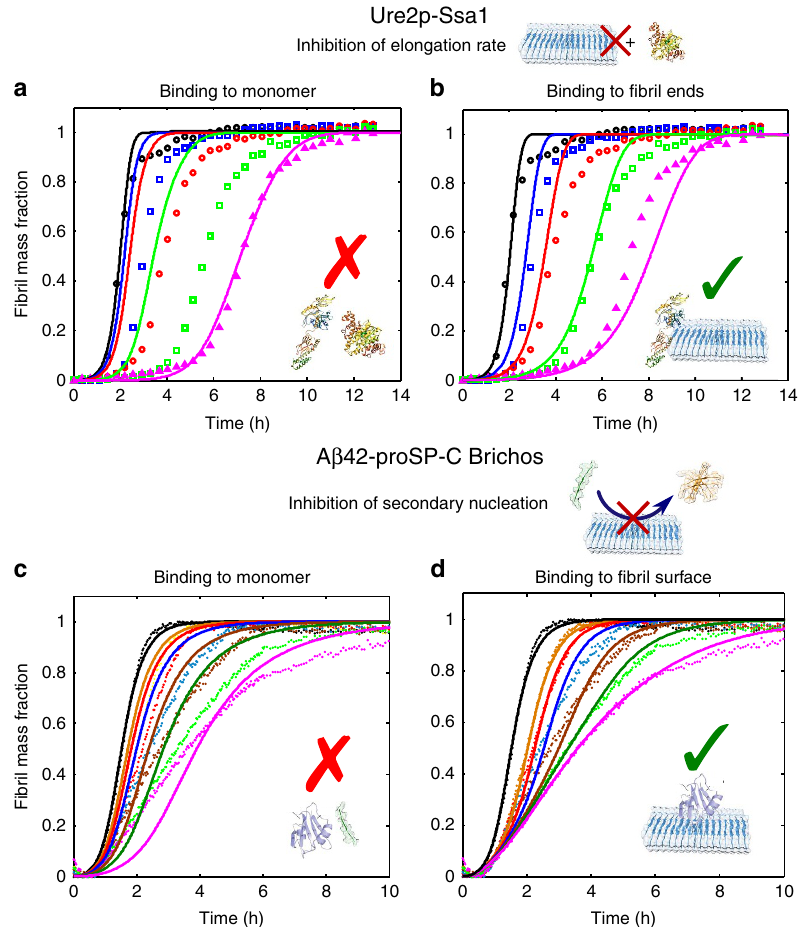
Figure 3 | Identification of the target species interacting with different molecular chaperones. Two specific sets of data taken from the literature 32,33 are re-analysed in the frame of the novel kinetic model developed here. The reaction profiles at different molecular chaperone concentrations are compatible with binding to the fibril ends in the case of the Ure2p-Saa1 system ( a , b ) and to the fibril surface in the case of the A b 42-Brichos system ( c , d ). The global fitting was performed by applying the set of equations reported in the Supplementary Equations